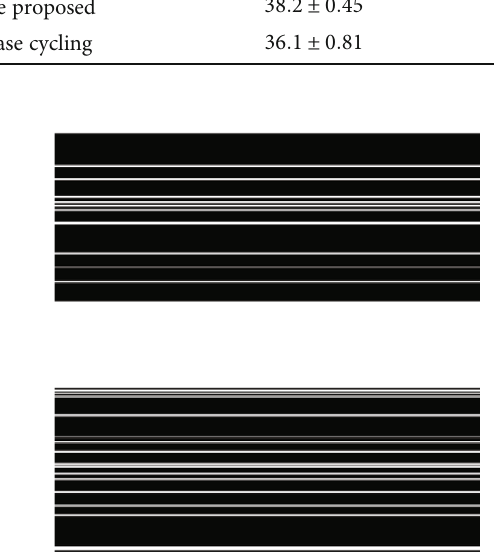
Figure 5: The sampling